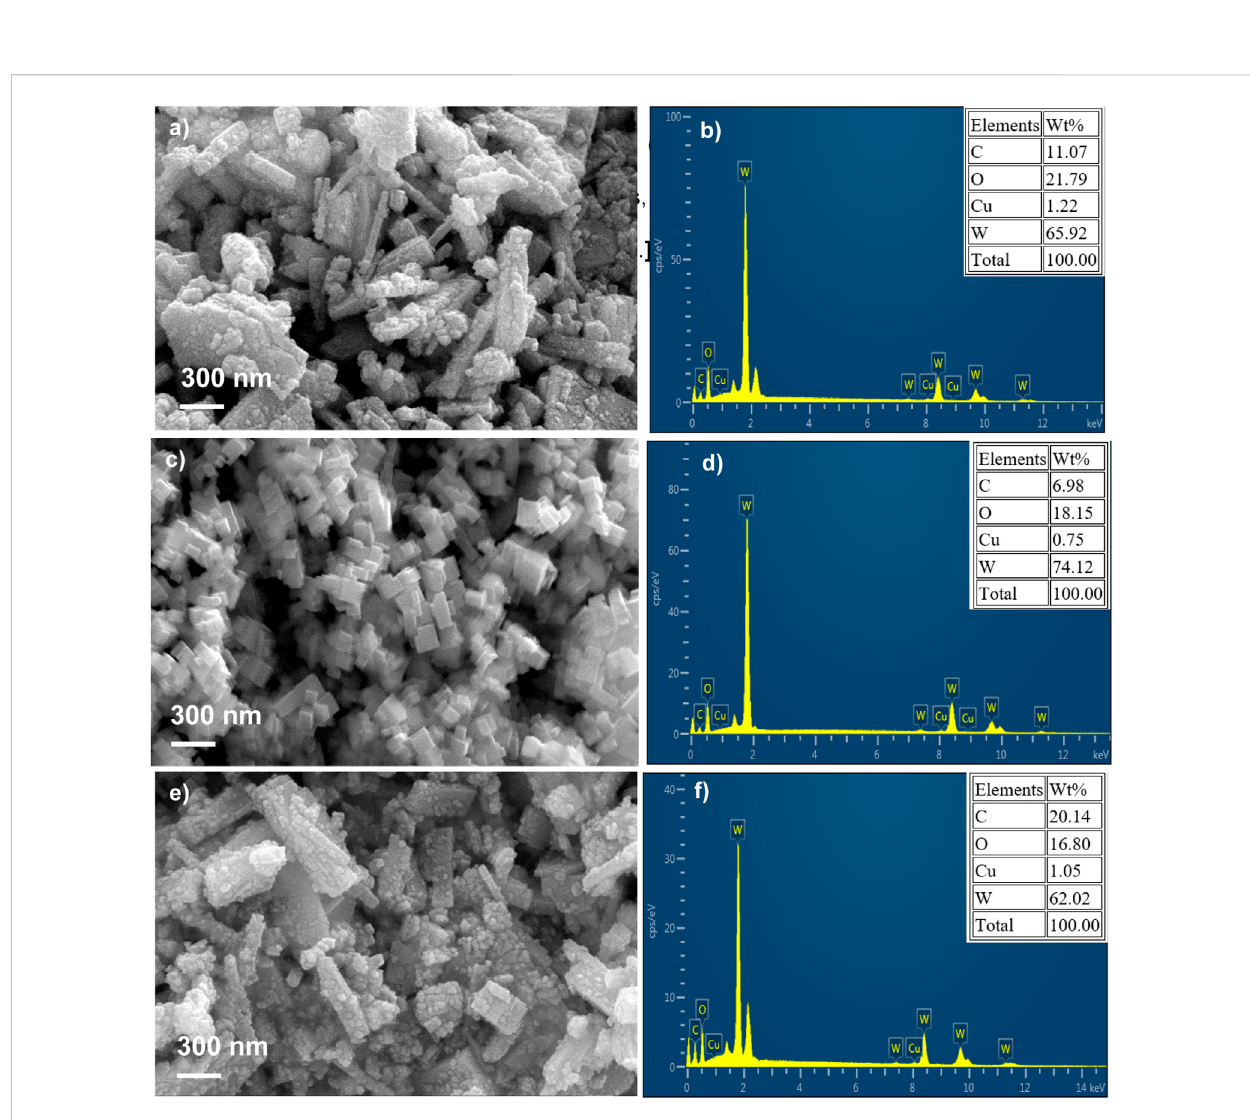
FIGURE 2 Scanning electron microscope (SEM) micrographs and their corresponding energy dispersive x-rays (EDX) of WO 3 samples synthesized using different acids (A, B) HNO3, (C, D) H 2 SO 4 , (E, F) HCl.